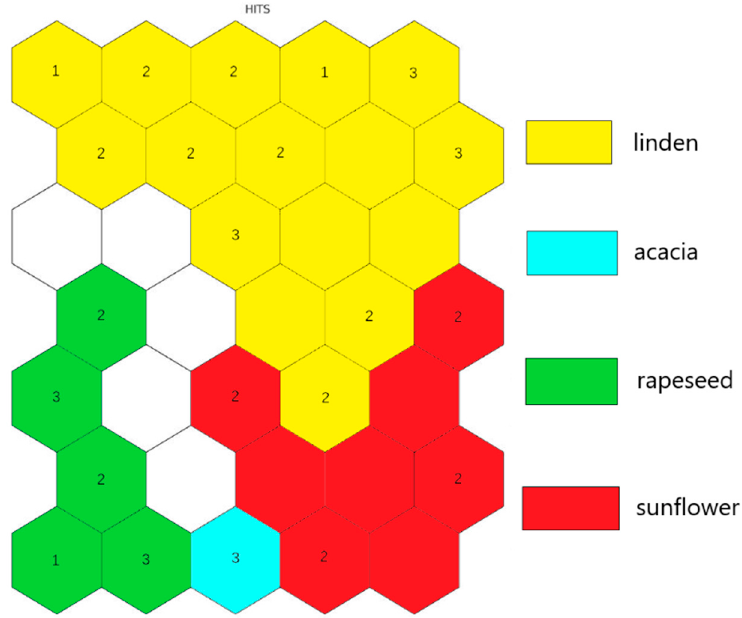
Figure 3. The HIT diagram of training set with the set of descriptors.